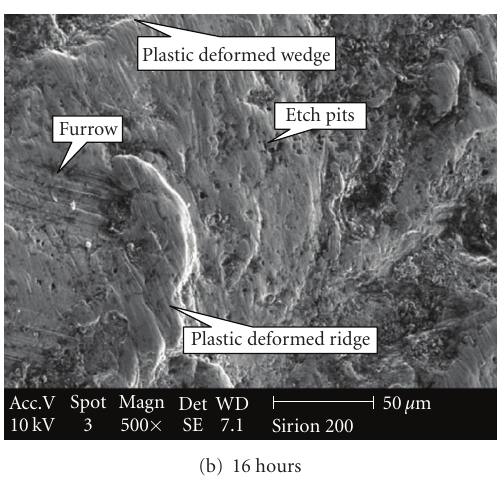
Figure 3: Worn surface morphology after impact-corrosion wear for 8 hours and 16 hours at the impact energy of 0.7J.